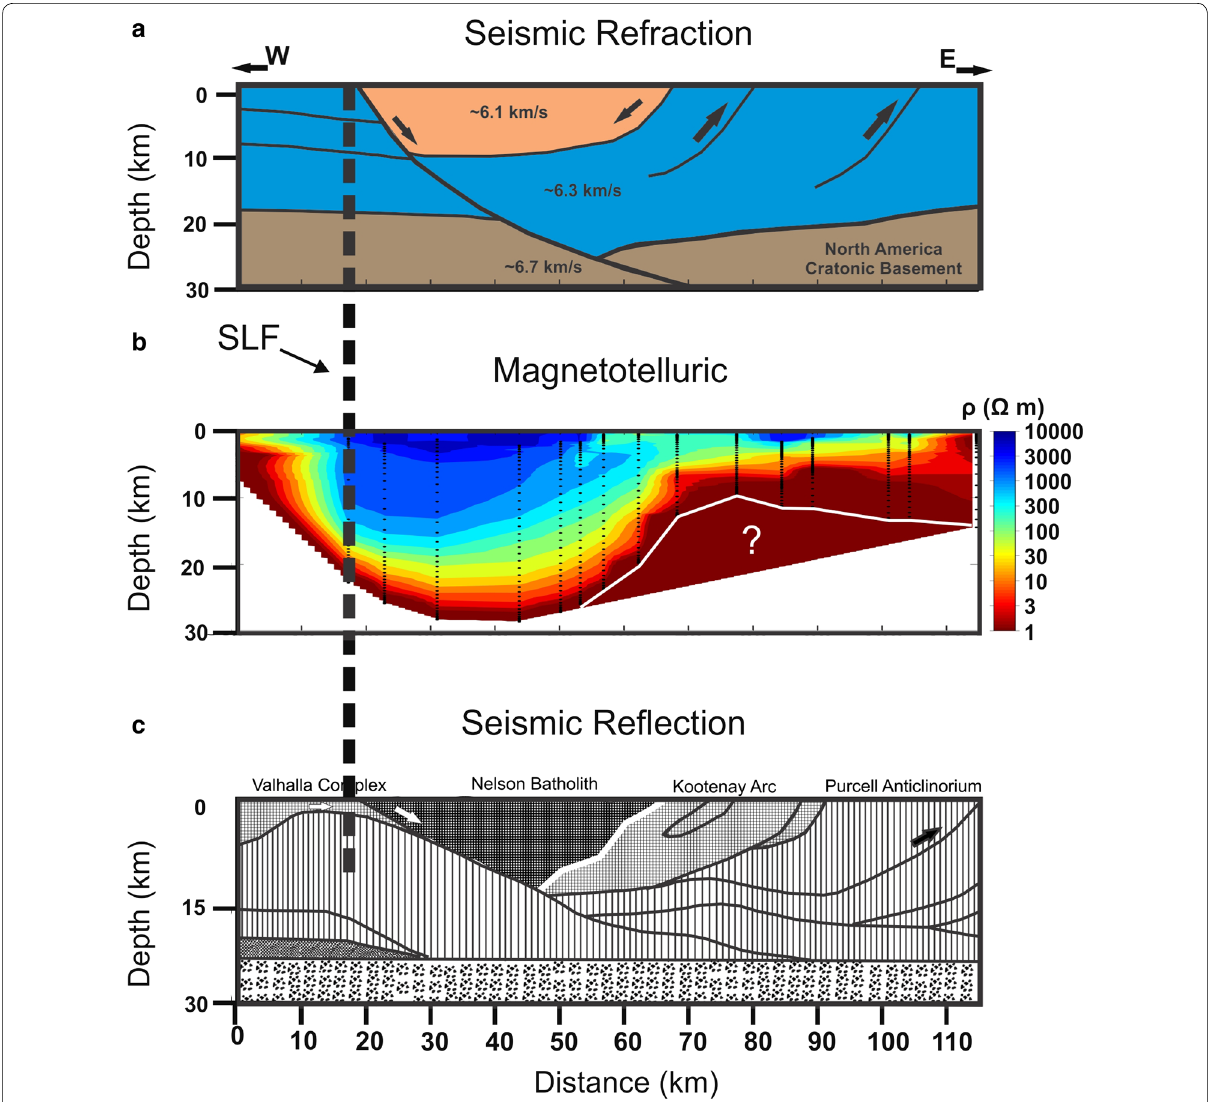
TM . c Seismic reflection model + ↔